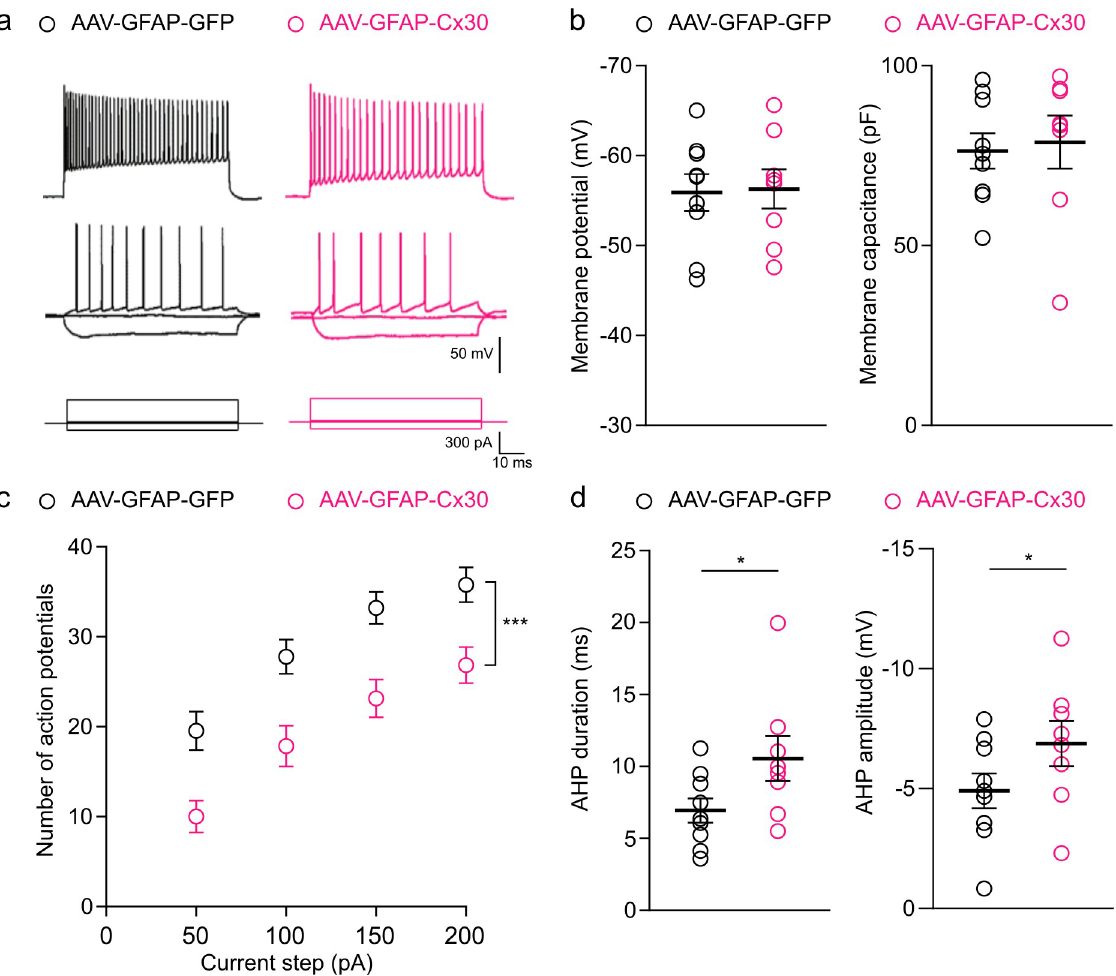
Fig 5. Upregulation of Cx30 impairs pyramidal cell excitability and action potential properties. (a) Typical electrophysiological response of CA1 pyramidal cells from control and Cx30 enhanced expression mice. CA1 pyramidal cells were recorded using whole-cell patch-clamp recordings in response to current pulses (bottom traces). Strong depolarizing current (top trace) evoked a high and sustained firing. ( b) Resting membrane potential and membrane capacitance were unchanged in CA1 pyramidal cells from mice injected with AAV-GFAP-GFP ( n = 9 neurons from 5 mice) or AAV-GFAP-Cx30 ( n = 8 neurons from 5 mice; p = 0.9825 for membrane potential, p = 0.4807 for membrane capacitance, Mann–Whitney test). ( c) Excitability curve with the number of action potentials evoked by current step for AAV-GFAP-GFP ( n = 9 neurons from 5 mice) and AAV-GFAP-Cx30 ( n = 8 neurons from 5 mice) transduced mice (AAV: *** p < 0.0001, F (1, 71) = 46,6; current step: *** p < 0.0001, F (4, 71) = 101.8, two-way ANOVA). ( d) AHP duration and amplitude were increased for AAV-GFAP-Cx30 ( n = 8 neurons from 5 mice) compared to AAV-GFAP-GFP ( n = 9 neurons from 5 mice) transduced mice. Individual numerical values are indicated in S1 Data. * p < 0.05, Mann–Whitney test. AAV, adeno-associated vector; AHP, afterhyperpolarization; fEPSP, field excitatory postsynaptic